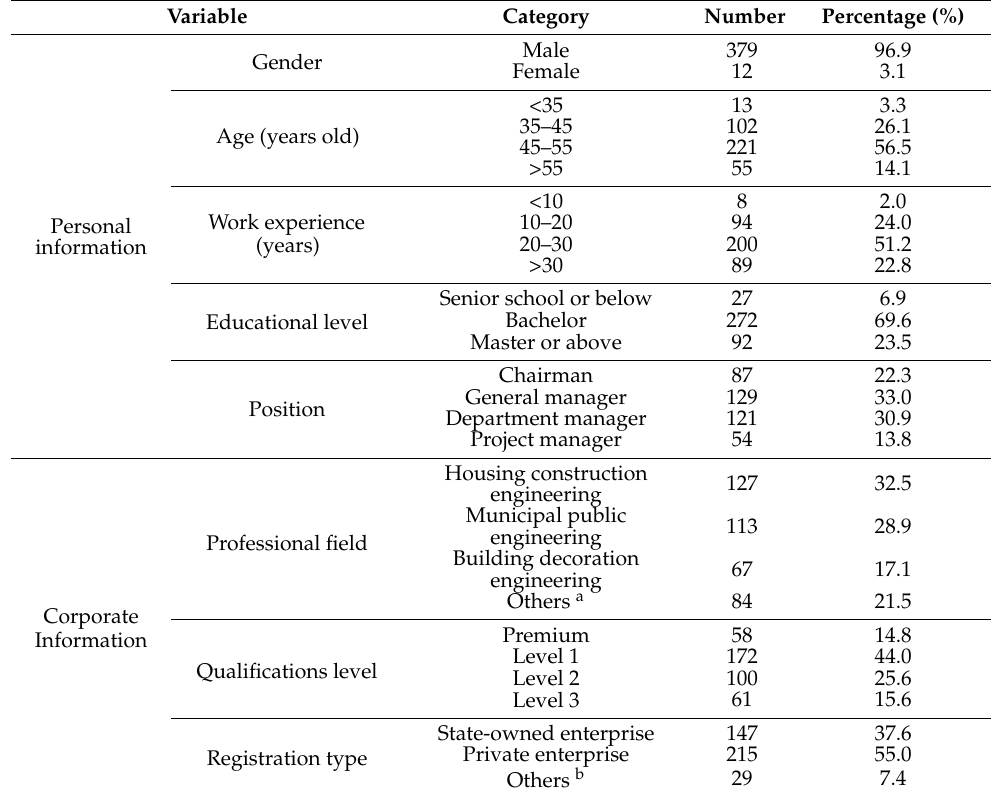
Table 1. Statistics of the respondents and their